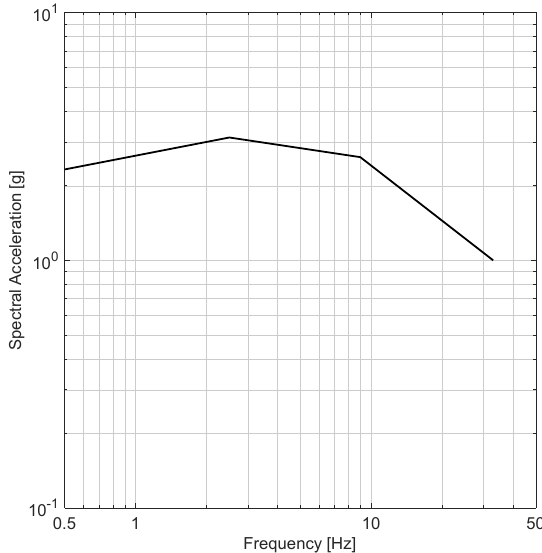
Figure 16. Response spectrum required according to RG 1.60 related to the PGA of 1.0 g, 5% damped.